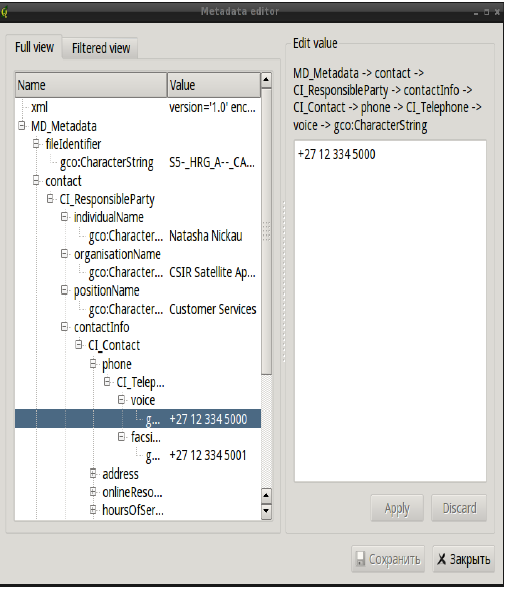
Figure 5. MetaTools user interface